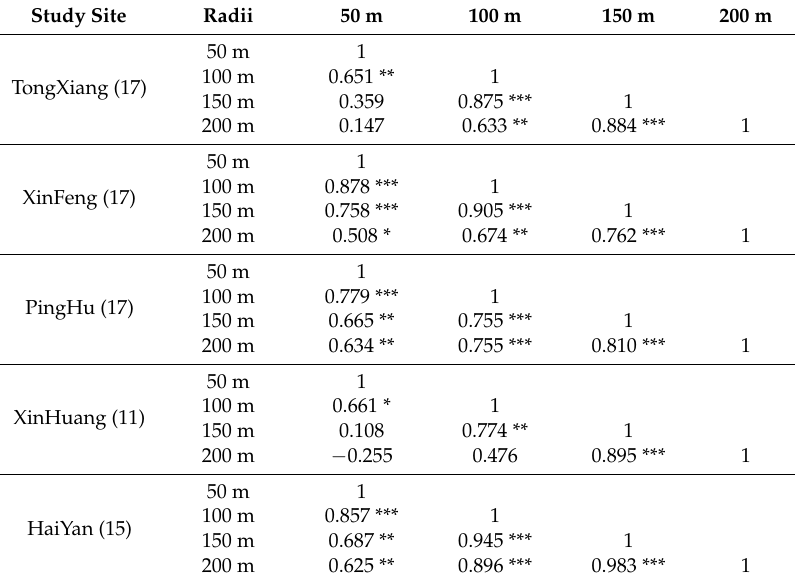
Table 3. Correlation coefficients between proportions of agricultural land to the buffer zone area at four radii. Study